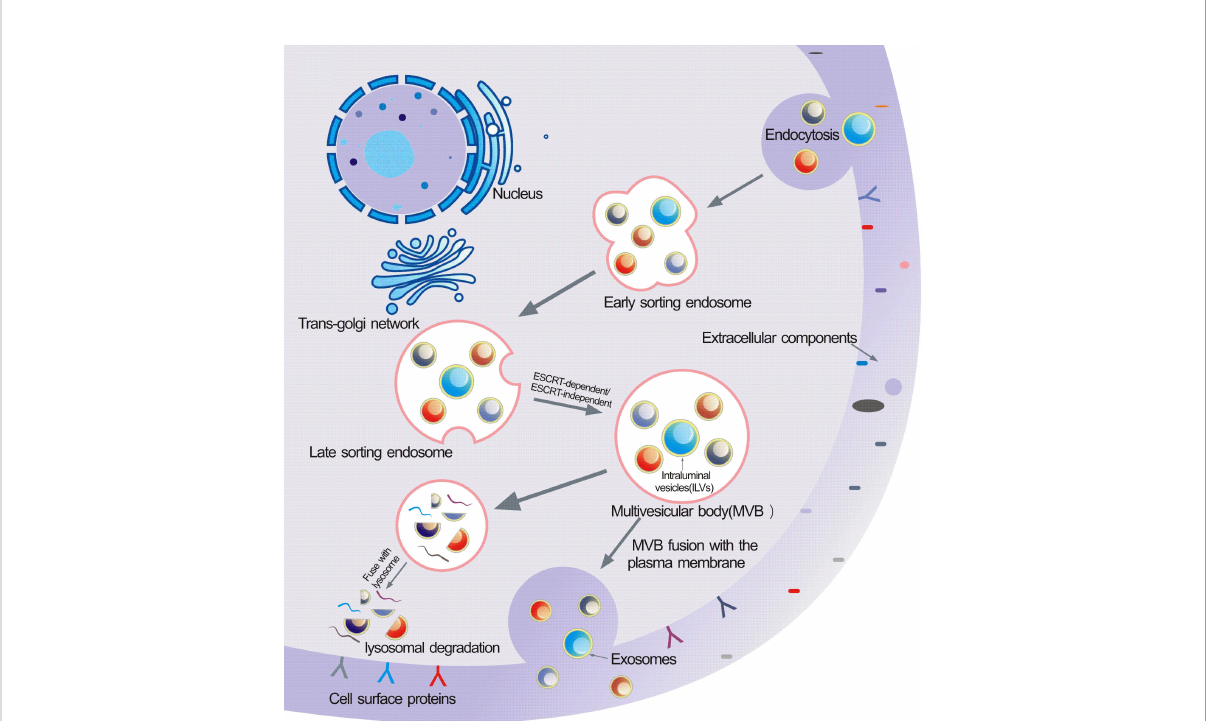
FIGURE 1 Schematic illustration of exosomes biogenesis. Extracellular constituents along with cell surface proteins enter cells through endocytosis of plasma membrane segments. Early sorting endosome (ESE) are formed after the inward budding of the plasma membrane, then they transport from ESE to late sorting endosome (LSE).Invagination in the LSE results in the multivesicular body(MVB)generation containing Intraluminal vesicles(ILVs).Several machineries including ESCRT-dependent and ESCRT-independent are involved in this process. MVB then can either fuse with lysosomes for degradation or be released into the extracellular space by fusing with the plasma